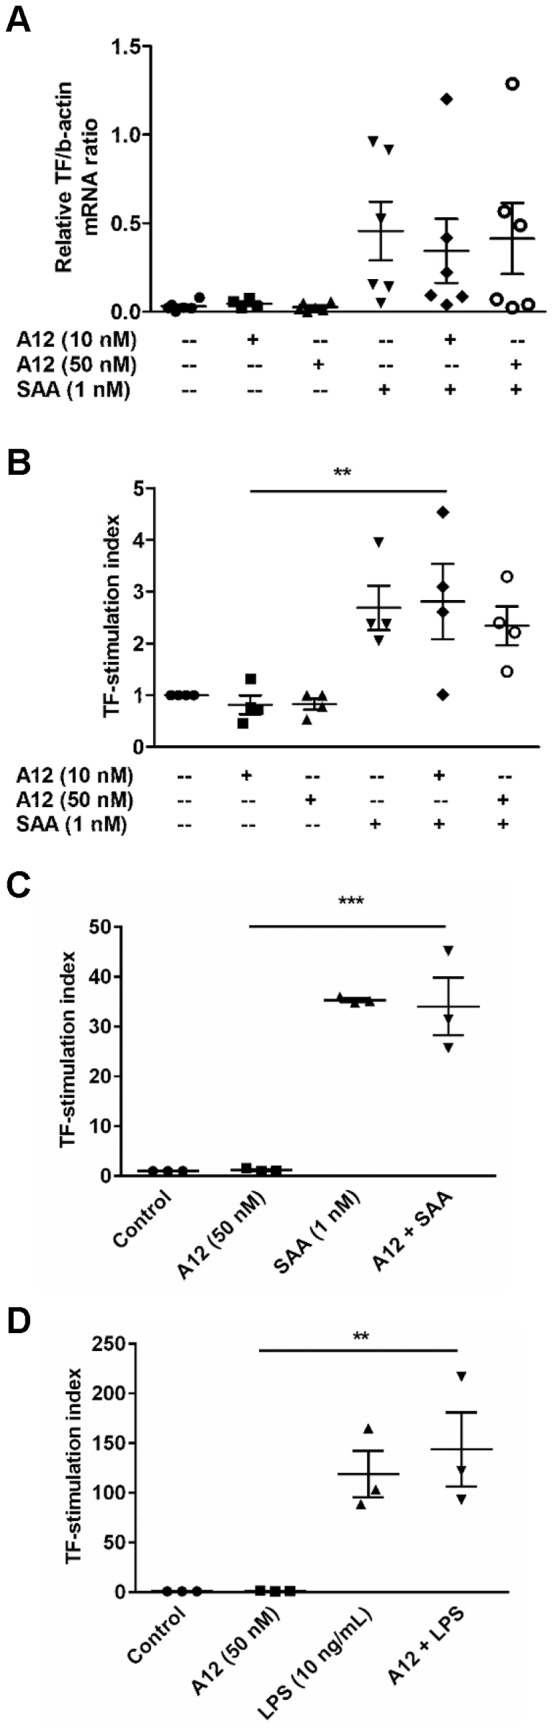
S100A12 did not suppress SAA-induced TF.(A) PBMC treated with SAA (1 nM), S100A12 (10 or 50 nM), or S100A12+ SAA for 2 h, and mRNA levels quantitated relative to β-actin mRNA; means ± SEM of duplicate measurements of PBMC from six independent donors (analyzed by one-way ANOVA with Bonferroni’s correction for multiple comparison tests). (B) PBMC stimulated as in (A) for 5 h, and PCA of cell lysates measured. Data expressed as TF-stimulation index (ratio of PCA of stimulated cells divided by PCA of unstimulated cells); values are means ± SEM mU TF activity assessed as recalcification time of duplicate assays using PBMC from four individual donors. **p<0.01 compared to S100A12 (10 nM)-stimulated cells (analyzed by one-way ANOVA with Bonferroni’s correction for multiple comparison tests). To determine effects of S100A12 on SAA or LPS-induced extracellular TF activity, PBMC were treated with (C) SAA (1 nM) ± S100A12 (50 nM) or (D) LPS (10 ng/ml) ± S100A12 (50 nM) in NUNC-minisorp tubes for 5 h and PCA of whole cells measured. Data expressed as TF-stimulation indices; values are means ± SEM mU TF activity assessed as recalcification time of duplicate assays using PBMC from three individual donors. **p<0.01 and ***p<0.005 compared to S100A12 (50 nM)-stimulated cells (analyzed by one-way ANOVA with Bonferroni’s correction for multiple comparison tests).